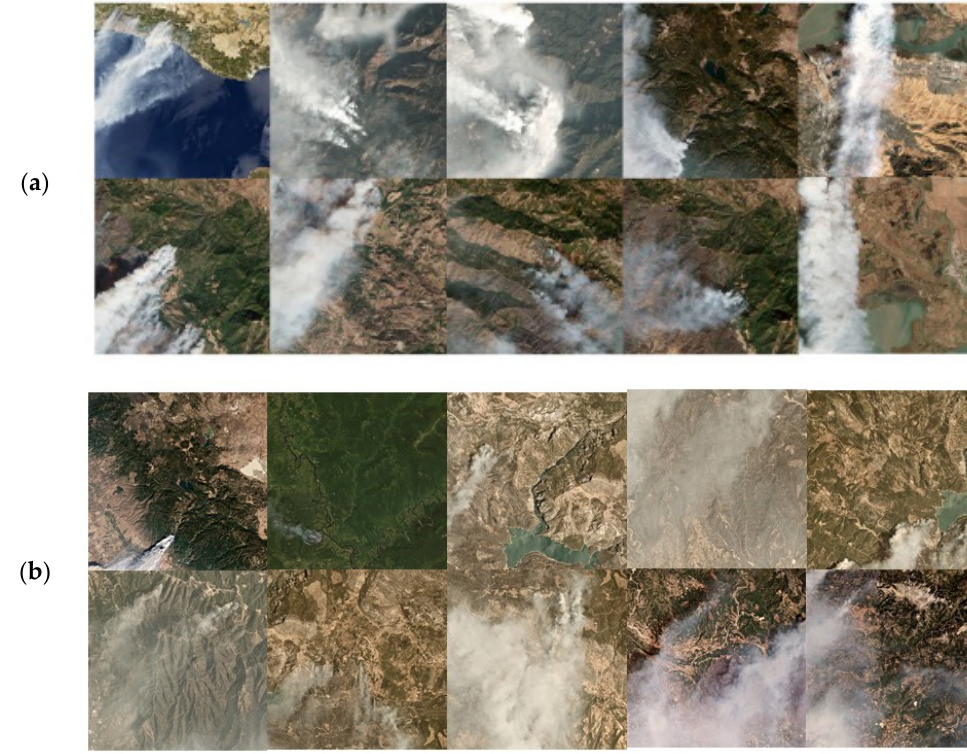
Figure 13. F1 score of wildfire results using MiniVGGNet model with different input pixel sizes and optimizer types.